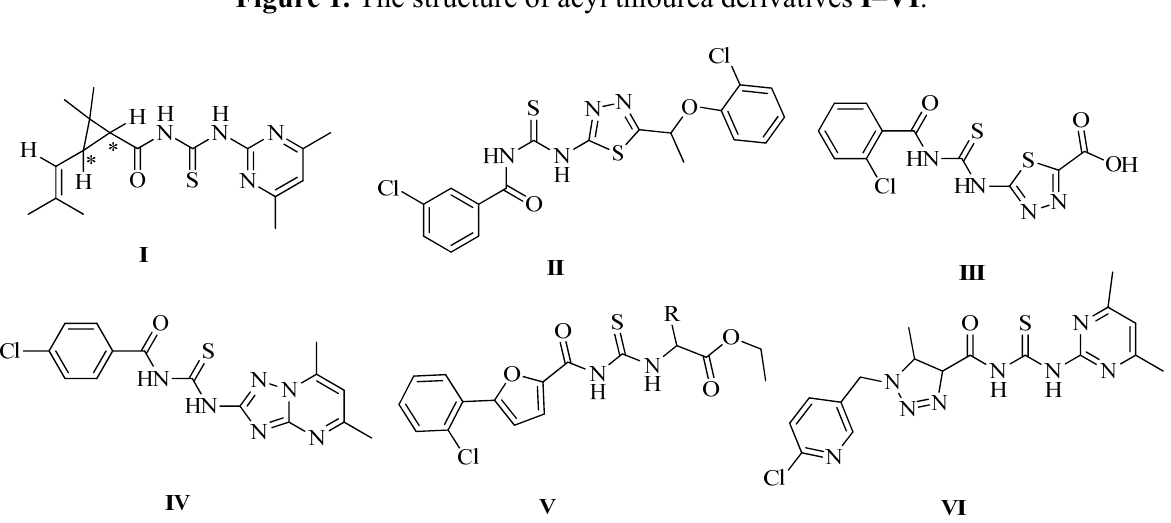
Figure 1. The structure of acyl thiourea derivatives I – VI